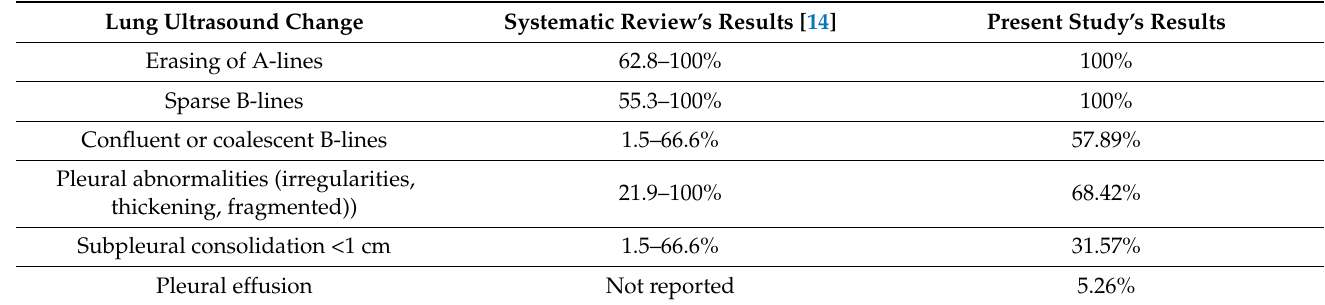
Table 5. The comparison between systematic review results and present study